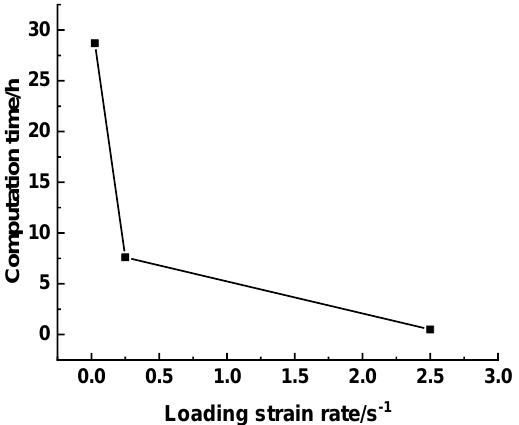
Figure 6. Influence of the loading strain rate on the elapsed time. The stress–strain curves obtained from the three loading strain rates are shown in Figure 7. The strain was recorded on the loading walls. The cold crushing strength and fracture energy were determined using Equations (7) and (8).